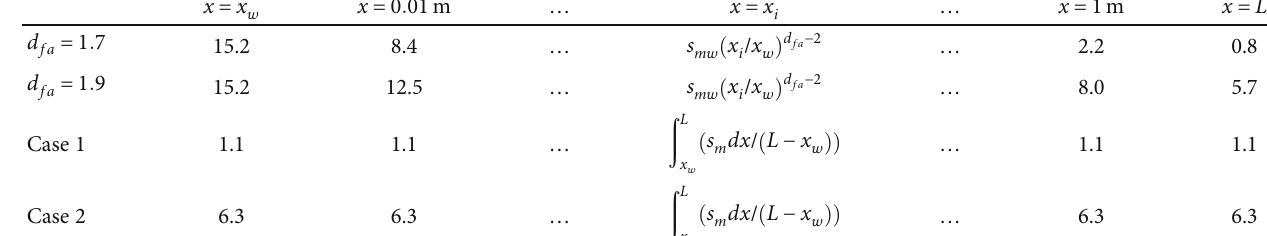
Table 1: The distribution of secondary fracture aperture with di ff erent cases (mm).